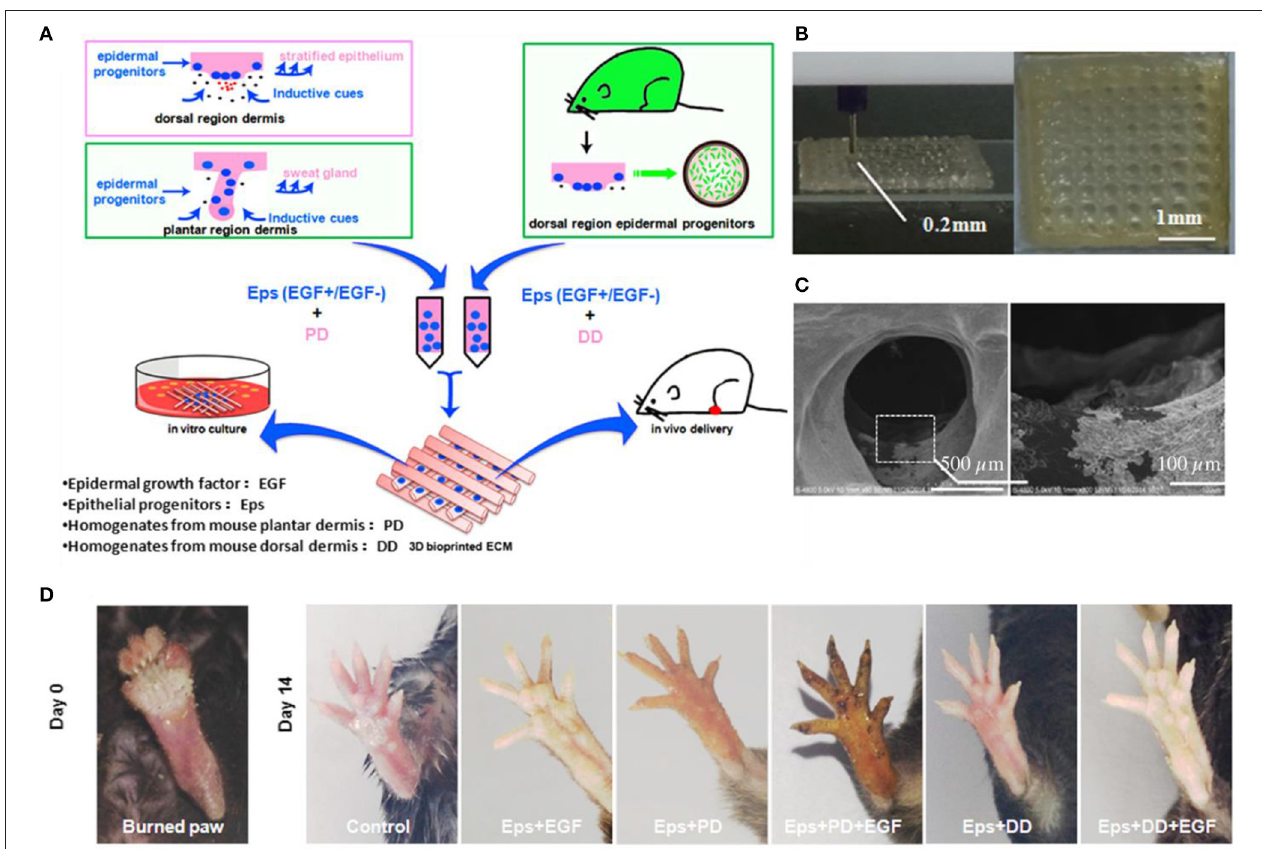
FIGURE 3 | 3D bioprinted scaffolds to direct the differentiation of epithelial progenitors for sweat gland regeneration. (A) Schematic of the printing process with epidermal progenitors and ECM incorporated in composite hydrogels. (B) Fabricated scaffold and (C) scanning electron microscopy (SEM) image of epidermal progenitor cells attached and spread out into the scaffold pores. (D) Iodine/starch-based sweat test on paws of mice at day 14 after surgery. Reprinted with permission from Huang et al. (2016). Copyright 2016,